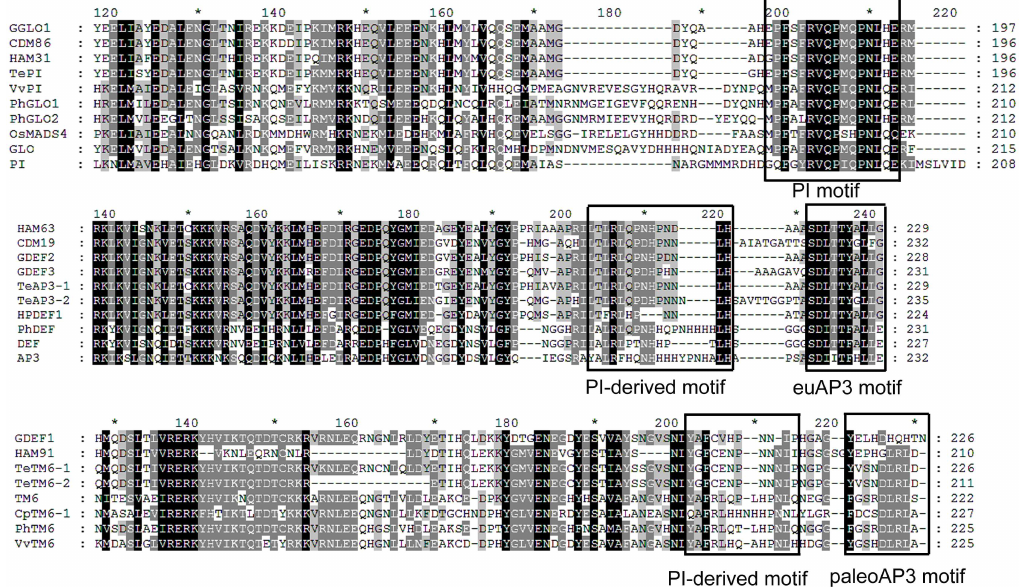
Fig 2. Comparison of the C-terminal region of amino acid sequences for MADS-box B class genes. TePI protein has the highly conservedsequencePI-motif in the C-terminal region.TeAP3-1 and TeAP3-2 have a PI-derived motif and a conservedeuAP3 motif in the C-terminal region. TeTM6-1 and TeTM6-2 shareda PI-derivedmotif and a characteristic ancestralpaleoAP3motif instead of a euAP3 motif at the C-terminal end. In additionto the five B class genes of T . erecta , GenBankaccessionnumbers of other PI/AP3-homologousgeneswere includedin Fig 3.